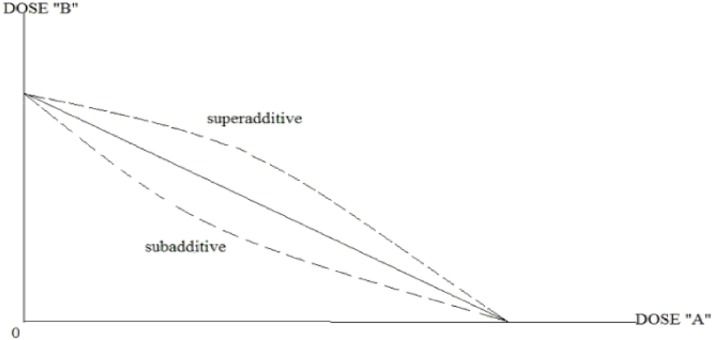
The typical subadditive and superadditive isoboles.